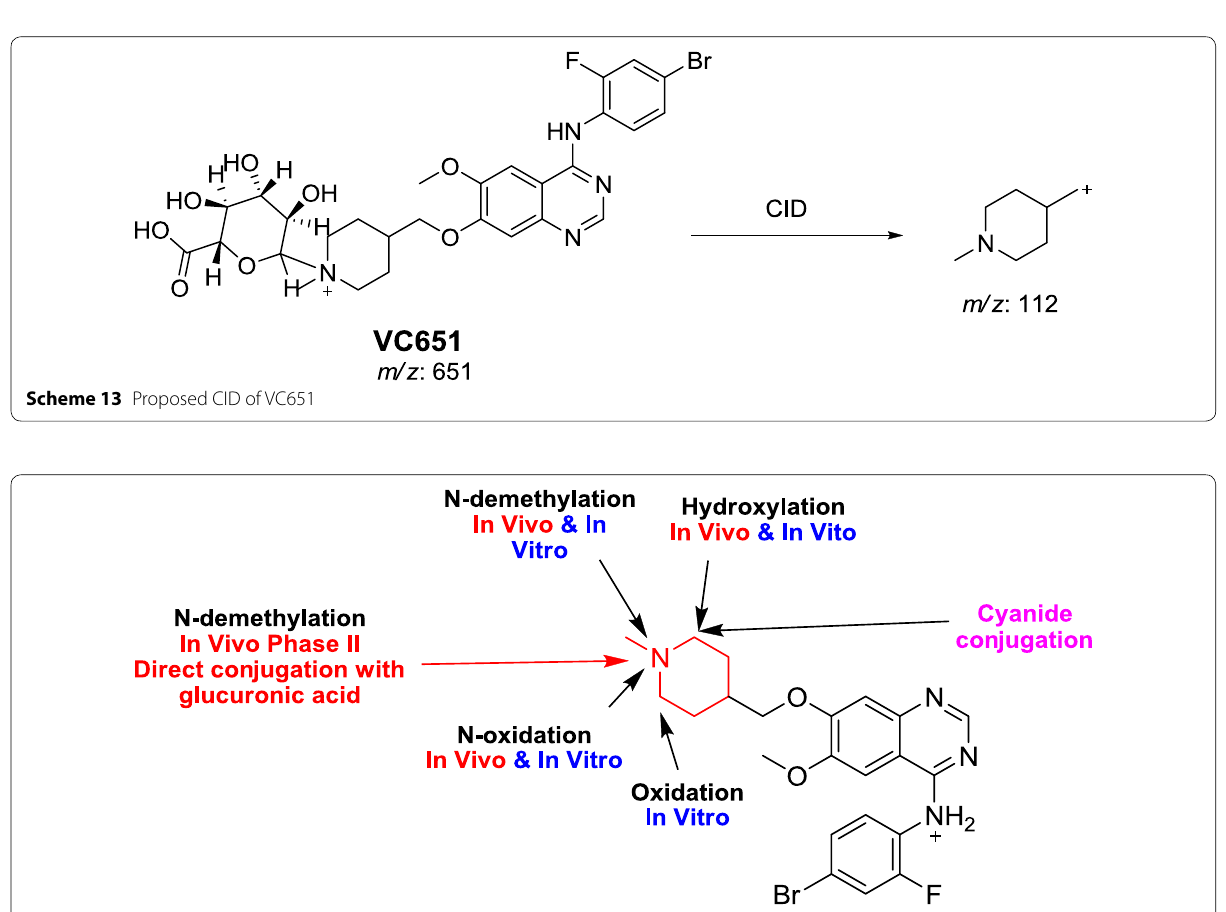
Fig. 10 Proposed in vitro metabolites, in vivo metabolites and cyano conjugates of